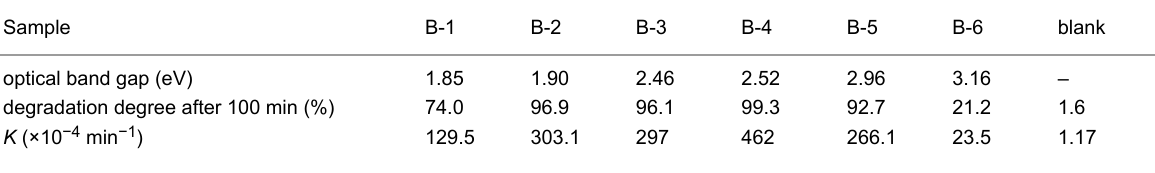
Table 1: The optical band gap, degree of degradation for 100 min and the reaction rate coefficient of the as-prepared samples as compared to the reference samples (blanks).